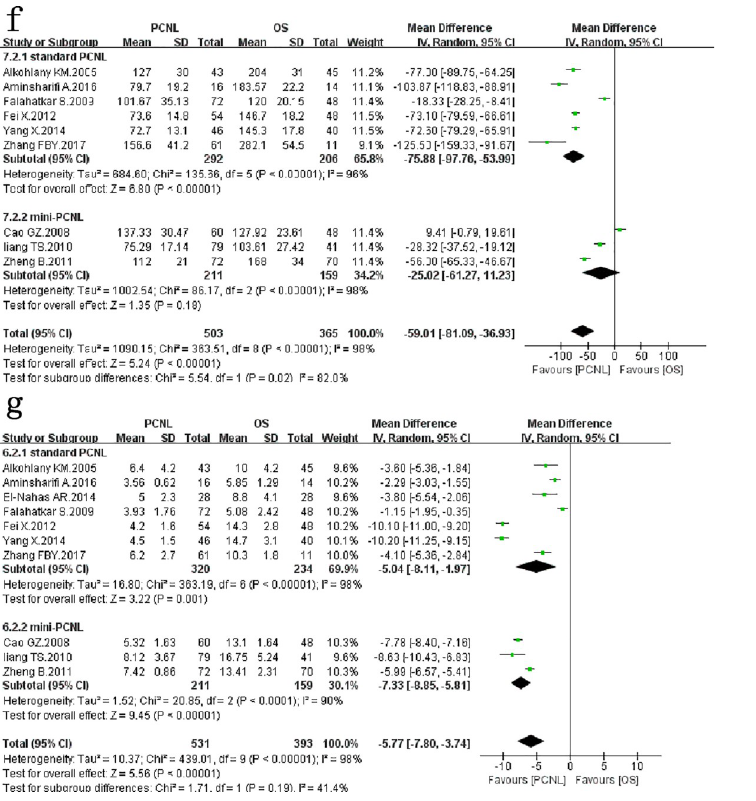
Fig 4. Forest plot and meta-analysis of operative times(f) and hospitalization times(g).